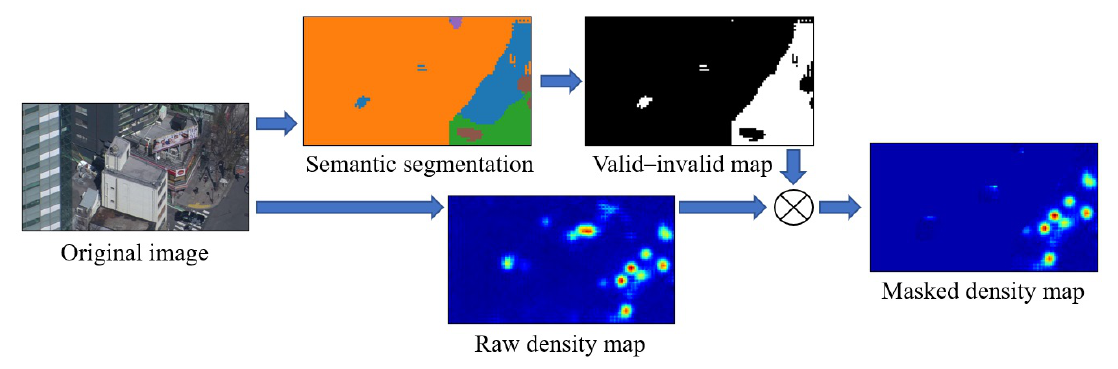
Figure 5. Flow of region-based masking